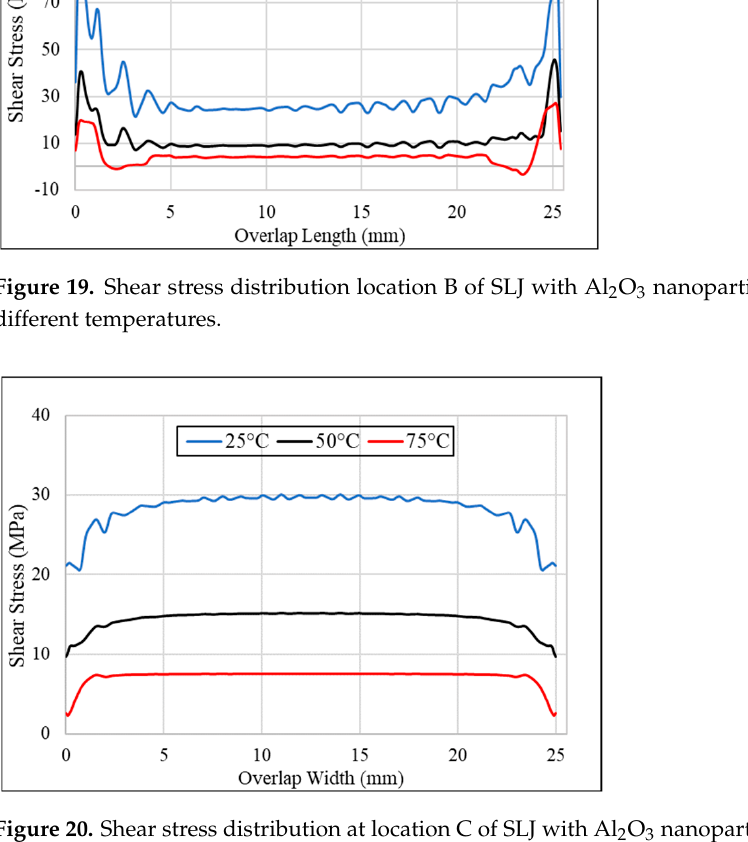
Figure 21. Shear stress distribution at location D of SLJ with Al 2 O 3 nanoparticles in the adhesive at different temperatures. Generally, at room temperature, peak peel and shear stresses experience reduction, whereas the peak stresses are increased when the temperature increases. Taking the case of stresses at location B, adding the nanoparticles at 25 °C decreased the peel stress by 2%, which signified that the adhesive material became less stiff. The peak peel and peak shear stress reduced after the inclusion of the Al 2 O 3 nanoparticles. This reduction can be corre- lated by comparing Figures 7 and 15, which show similar behavior of reduction of peak peel and shear stresses. Table 3 also shows a significant reduction of over 19% in peak shear stress at room temperatures after adding Al 2 O 3 nanoparticles, signifying less stiff-